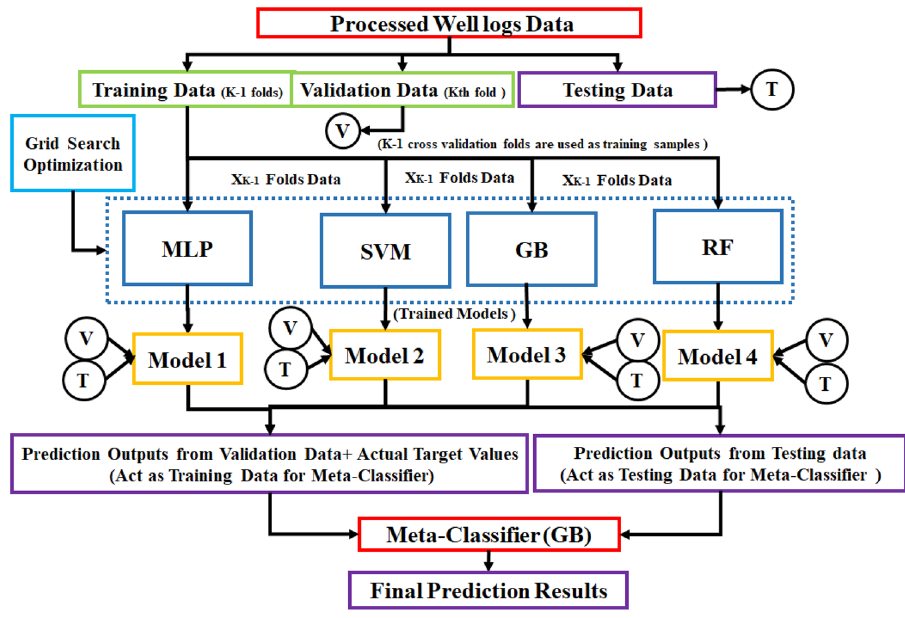
Fig. 1 Conceptual architecture of the stacking ensemble uti- lized for quantitative lithofacies modeling in this